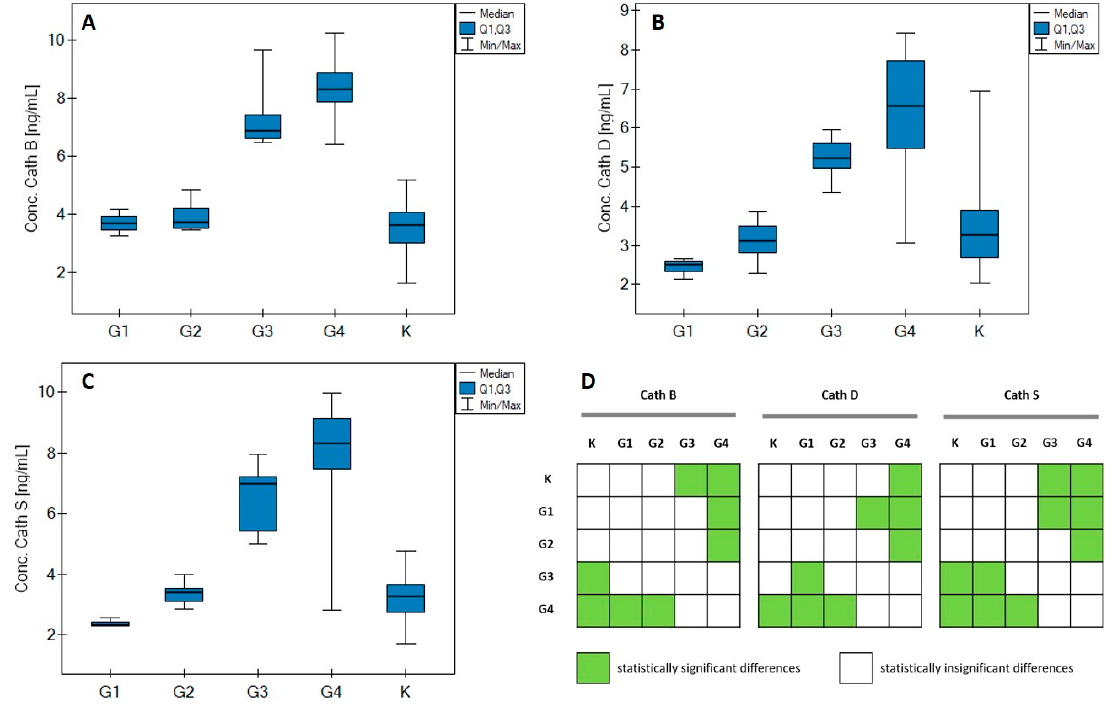
Figure 1. Changes in test concentrations of cathepsin: ( A ) cathepsin B, ( B ) cathepsin D, ( C ) cathepsin S, depending on the stage and in the control group. ( D ) graphical representation of Dunn Bonferroni’s test results.